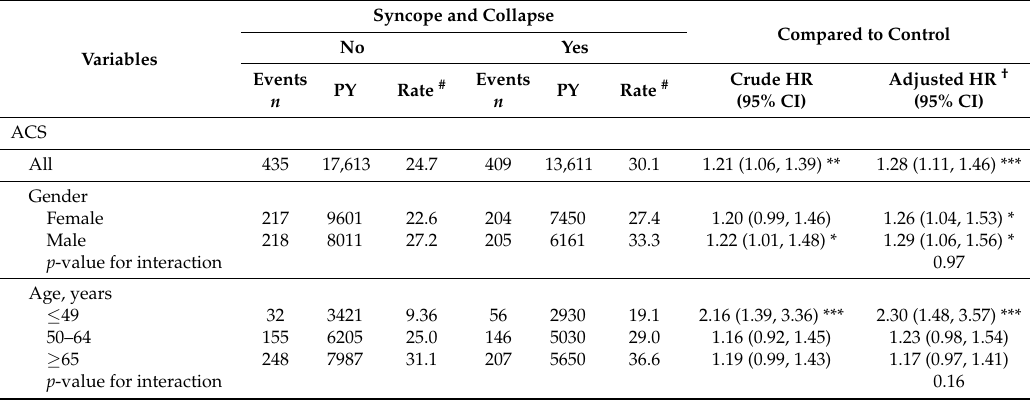
Table 3. Incidence and adjusted HRs of ACS, arrhythmia or cardiac arrest, stroke, and mortality based on sex, age, and comorbidities between patients undergoing dialysis with and without